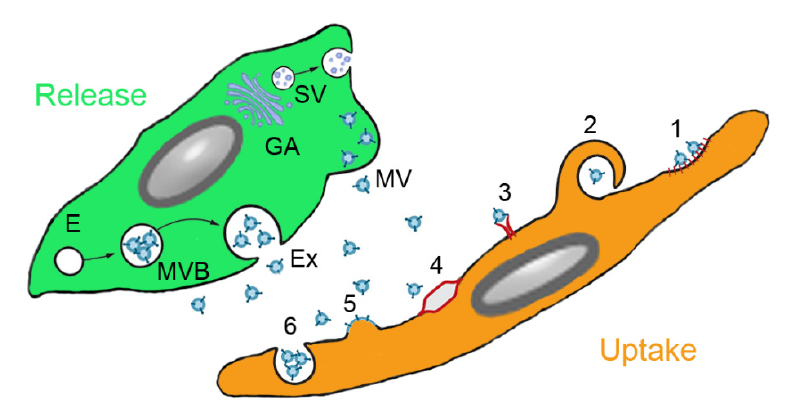
Figure 2. Paracrine secretion by mesenchymal stem cells (MSCs) and action on target cells. MSCs produce soluble molecules at the Golgi apparatus (GA) and release them as secretory vesicles (SV). Extracellular vesicles (EVs) are secreted either from endosomes (E) via multivesicular bodies (MVB) as exosomes (Ex) or by membrane budding as microvesicles (MV). EVs can be ingested by clathrin-or caveolin-mediated endocytosis (1), macropinocytosis (2), receptor-mediated uptake (3), lipid rafts (4), fusion with the plasma membrane (5) and phagocytosis (6) (routes according to [38]).